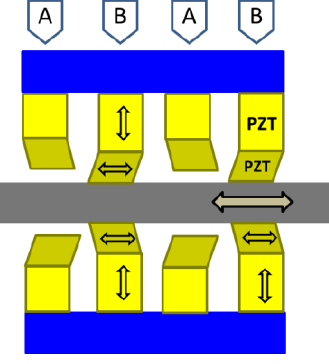
Figure 17. Piezo-walk drive motor at PI [24].